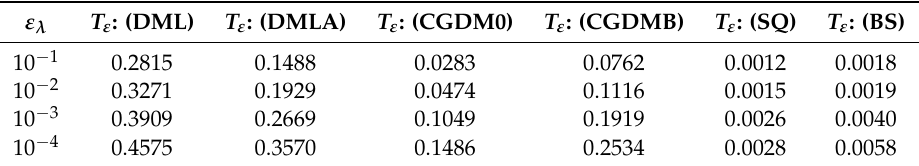
Table 7. Results for Case Q with J = 510, m =